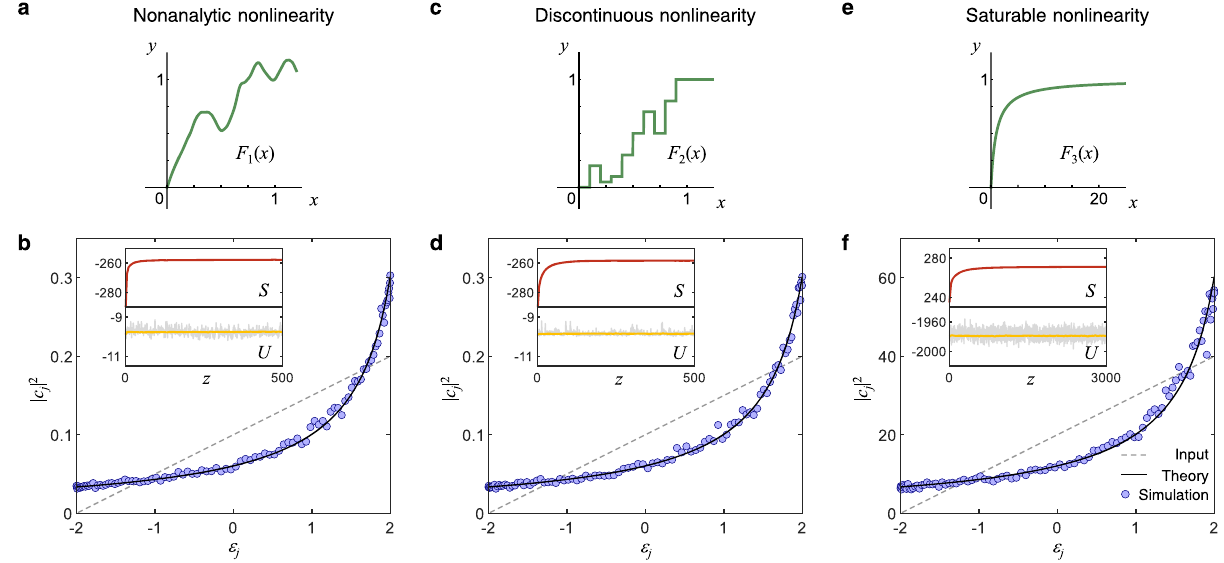
Fig. 3 | Thermalization of light in nonlinear lattices involving generalized (b) and (d), the initial excitation conditions are exactly the same and as a result intensity-dependent nonlinearities F ( x ). a An example of non-analytic function they attain the same RJ allocation, an aspect indicating universality in thermaliza- usedinoursimulations. b CorrespondingRayleigh – Jeans(RJ)distribution( T =0.15, tion.The insets have been plotted in a manner similar to Fig. 2. As before, here μ = − 2.5)occurringafterthermalization. c Adiscontinuousmulti-stepfunctionused we used M =100 and the initial mode occupancies are represented by the inoursimulations. d AgainthisnonlinearityleadstoaRJdistribution. e Asaturable dashed , and ( f ) its corresponding RJ distribution. In nonlinearity described by F 3 ð x Þ = x 1+ x